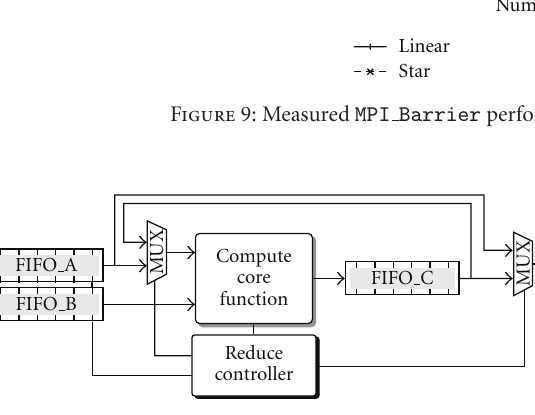
Figure 10: Block diagram of the hardware implementation of MPI Reduce .